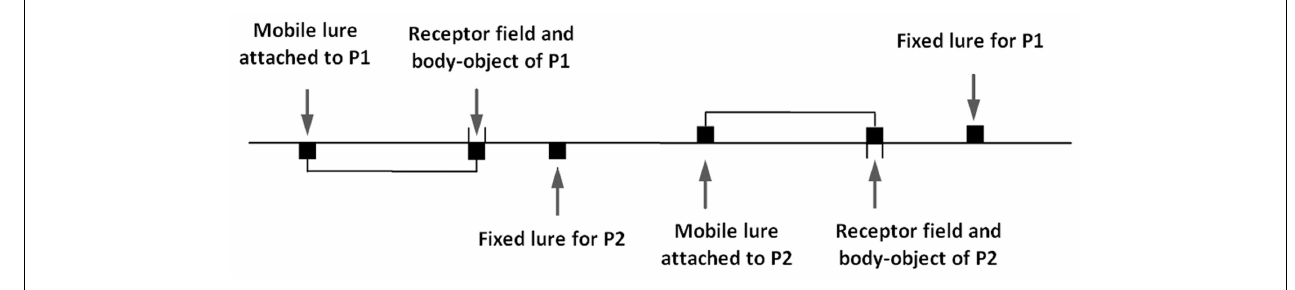
FIGURE 3 | Schematic illustration of the one-dimensional space explored by the subjects. Subject P1 receives a tactile stimulus whenever (s)he encounters either his fixed object, or the receptor field of subject P2, or the mobile object attached to the receptor field of P2.